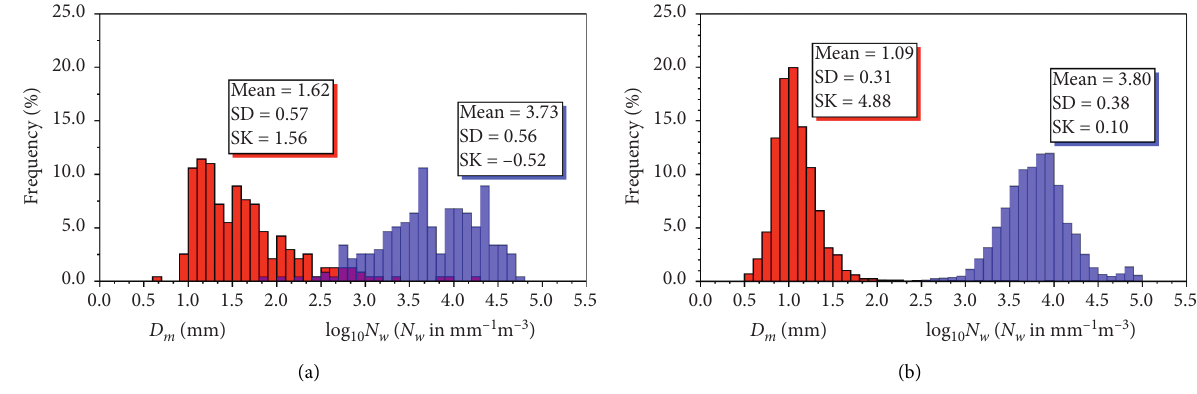
Figure 4: Same as Figure 3 but for convective rainfall (a) and stratiform rainfall Table 2: Statistics of DSD parameters for convective rainfall, stratiform rainfall, and an overall average of the two. Parameters